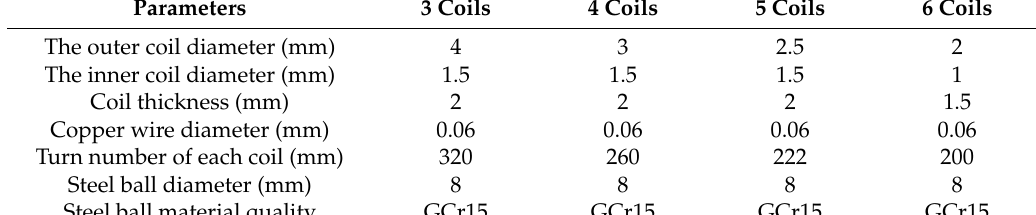
Table 2. The parameters for multi-coil probes in a CECA sensor under different arrangements and parameters of the measured steel ball.